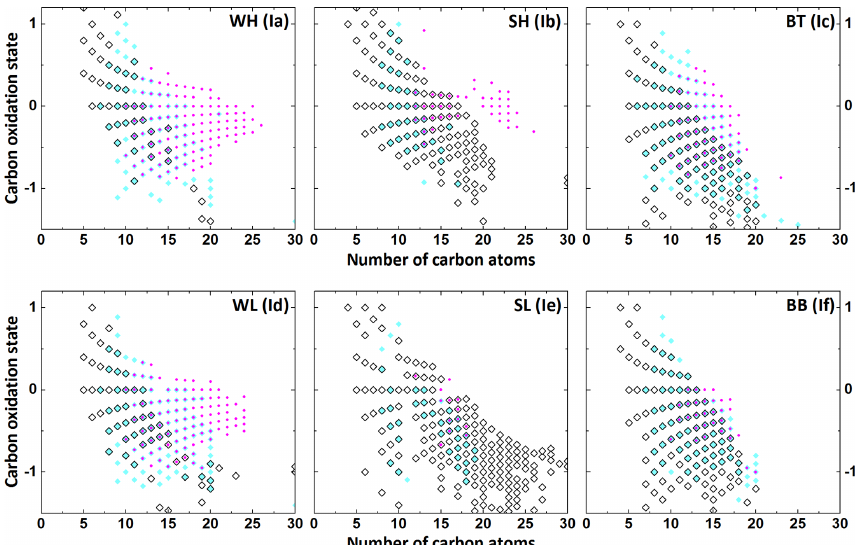
Figure 7. Plot of carbon oxidation state against carbon number for all CHO formulae in the WH, WL SH, SL, BT and BB samples. Polycyclic aromatic (2.7143 ≤ Xc), monocyclic aromatic (2.5000 ≤ Xc ≤ 2.7143) and non-aromatic (Xc ≤ 2.5000) formulae are depicted as magenta circles, cyan diamonds and open black diamonds